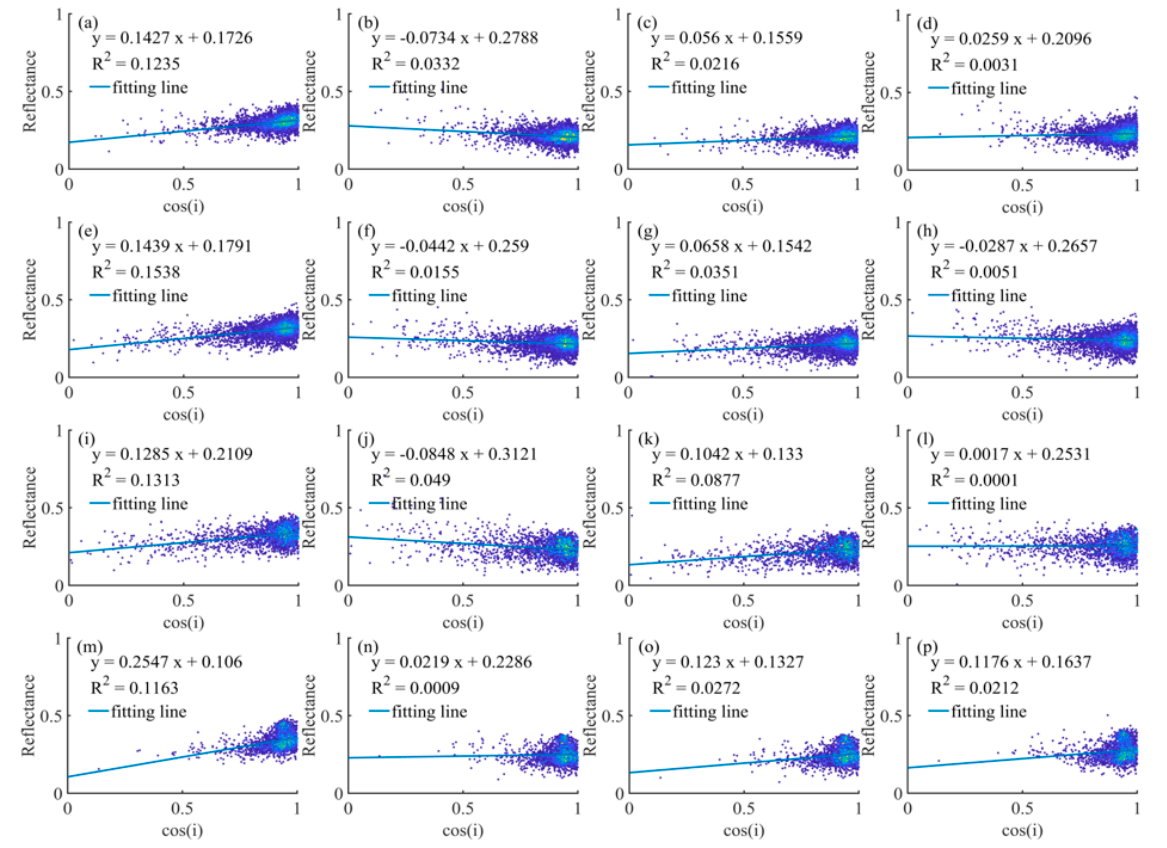
Figure 7. Density scatterplots between the reflectance of herb ( a – d ), shrub ( e – h ), tree ( i – l ), and bare soil ( m – p ) at 834.83 nm and the cosine of the local solar incidence angle (cos( i )). ( a ) Uncorrected, ( b ) SCS+C, ( c ) Minnaert+SCS, ( d ) RA-TOC-CA; ( e ) Uncorrected, ( f ) SCS+C, ( g ) Minnaert+SCS, ( h ) RA- TOC-CA; ( i ) Uncorrected, ( j ) SCS+C, ( k ) Minnaert+SCS, ( l ) RA-TOC-CA; ( m ) Uncorrected, ( n ) SCS+C, ( o ) Minnaert+SCS, ( p ) RA-TOC-CA.